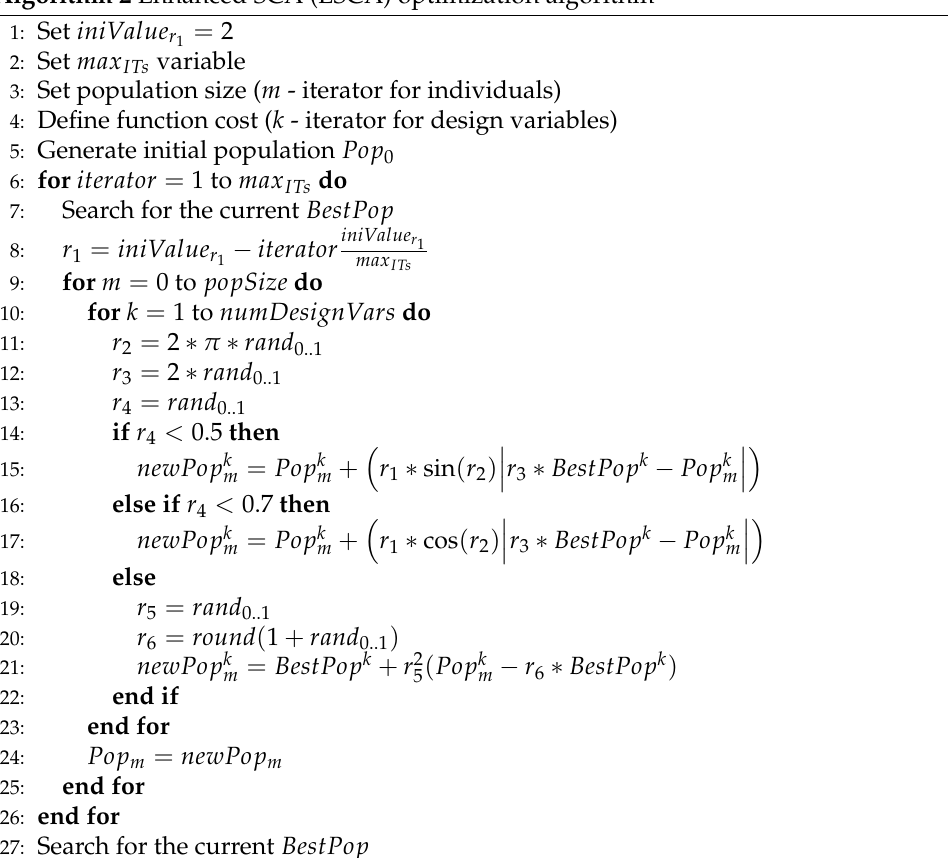
Algorithm 2 Enhanced SCA (ESCA) optimization